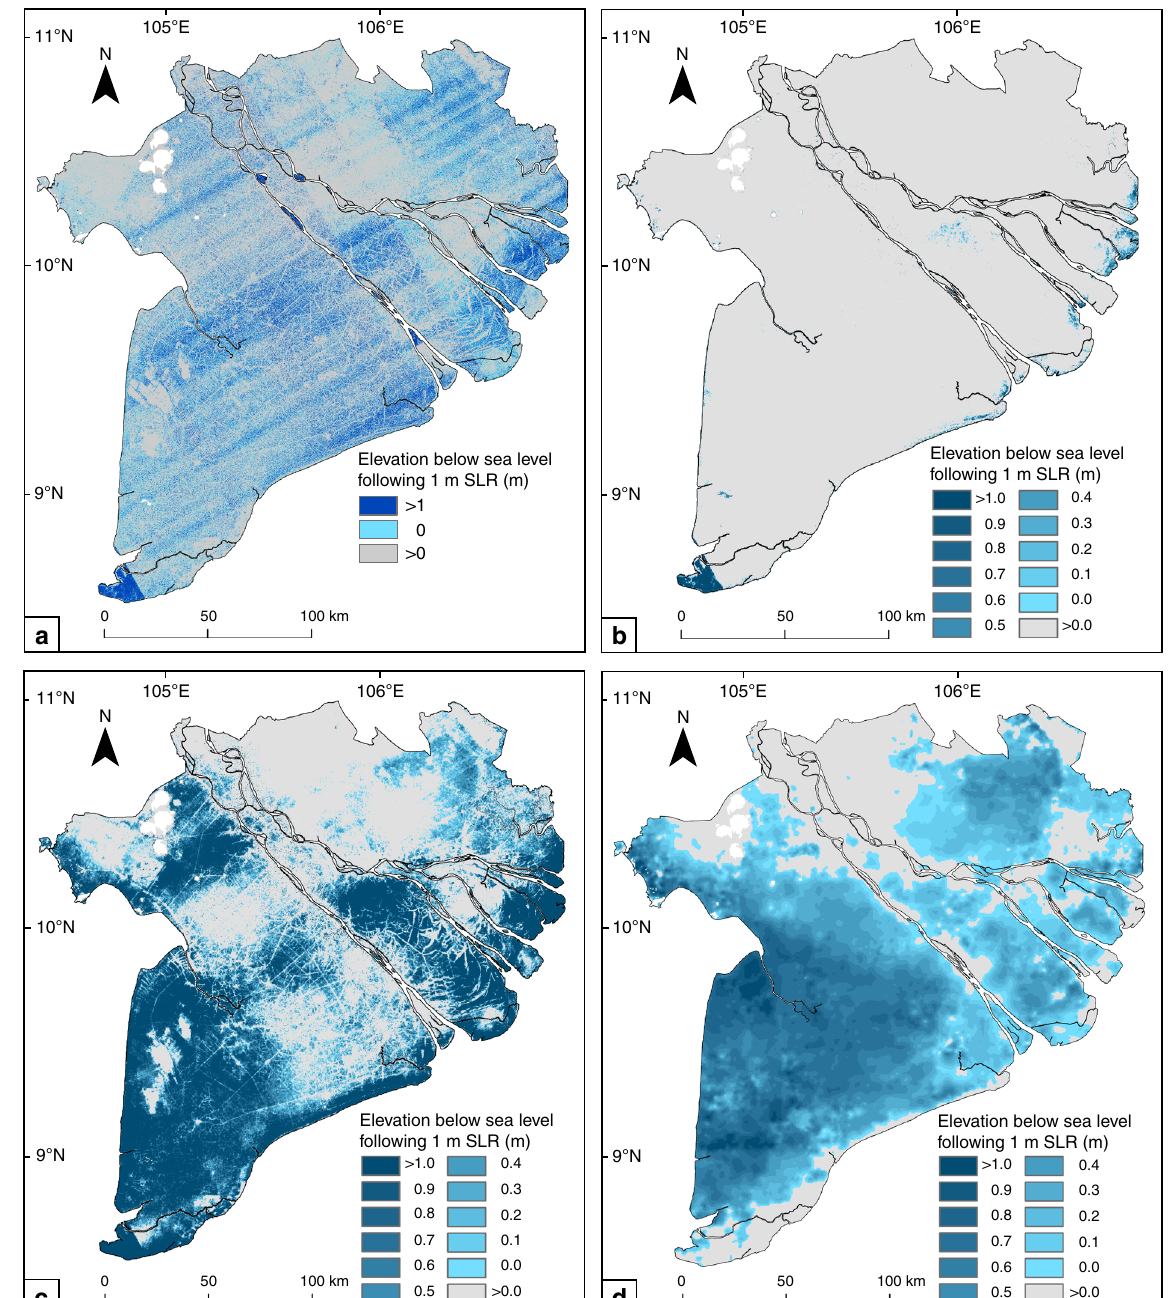
Fig. 7 Projections of area below sea level following sea-level rise. Projections of relative sea-level rise (SLR) are based on the a SRTM DEM, b the MERIT DEM, c the transposed MERIT DEM, and the d Topo DEM. The transposed MERIT DEM matches the mean delta elevation of the Topo DEM and was created by subtracting 2.5 m from the original MERIT DEM. Total area of the delta plain below sea level with 1 m SLR is 31% for the SRTM DEM, 2% for the MERIT DEM, 59% for the transposed MERIT DEM, and 75% for the Topo